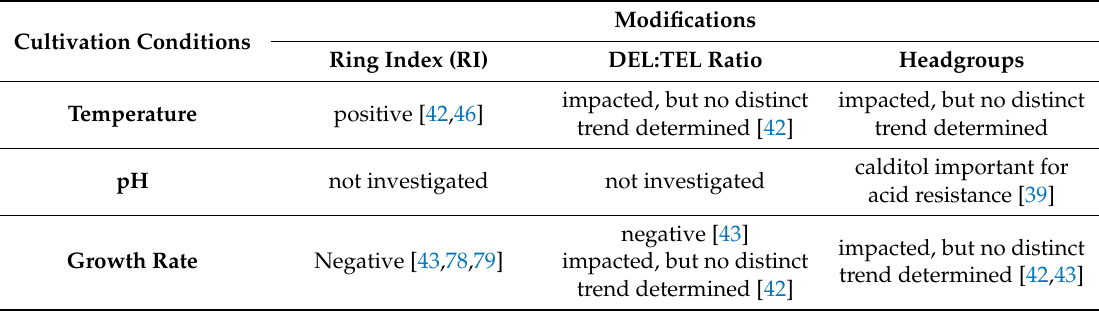
Table 2. Correlation between changes in temperature, pH and growth rate and the responses ring index (RI), diether to tetraether lipid ratio (DEL:TEL ratio) and headgroups in Sulfolobus spp. Modifications Cultivation Conditions Ring Index (RI) DEL:TEL Ratio Headgroups impacted, but no distinct impacted, but no distinct Temperature positive [42,46] trend determined [42] trend determined calditol important for pH not investigated not investigated acid resistance [39] negative [43] impacted, but no distinct Growth Rate Negative [43,78,79] impacted, but no distinct trend determined trend determined [42]